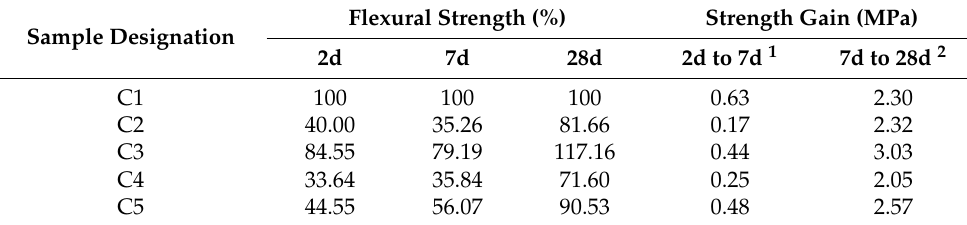
Table 8. Additional information obtained on the basis of flexural strength